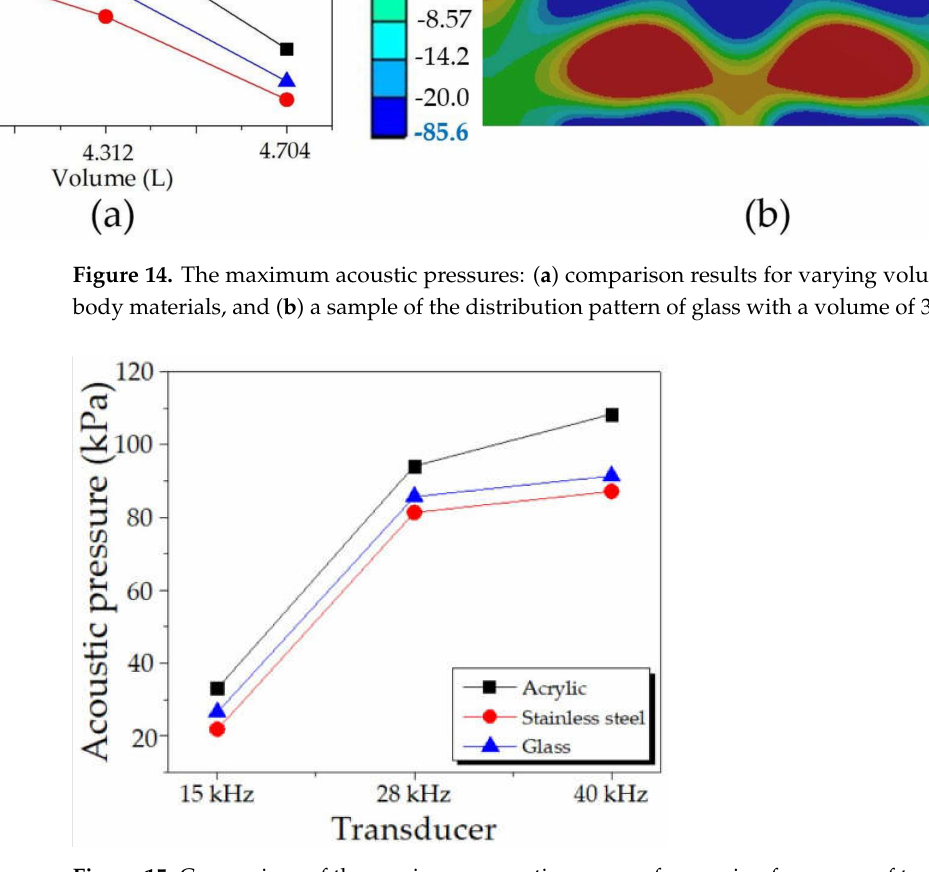
Figure 15. Comparison of the maximum acoustic pressure for varying frequency of